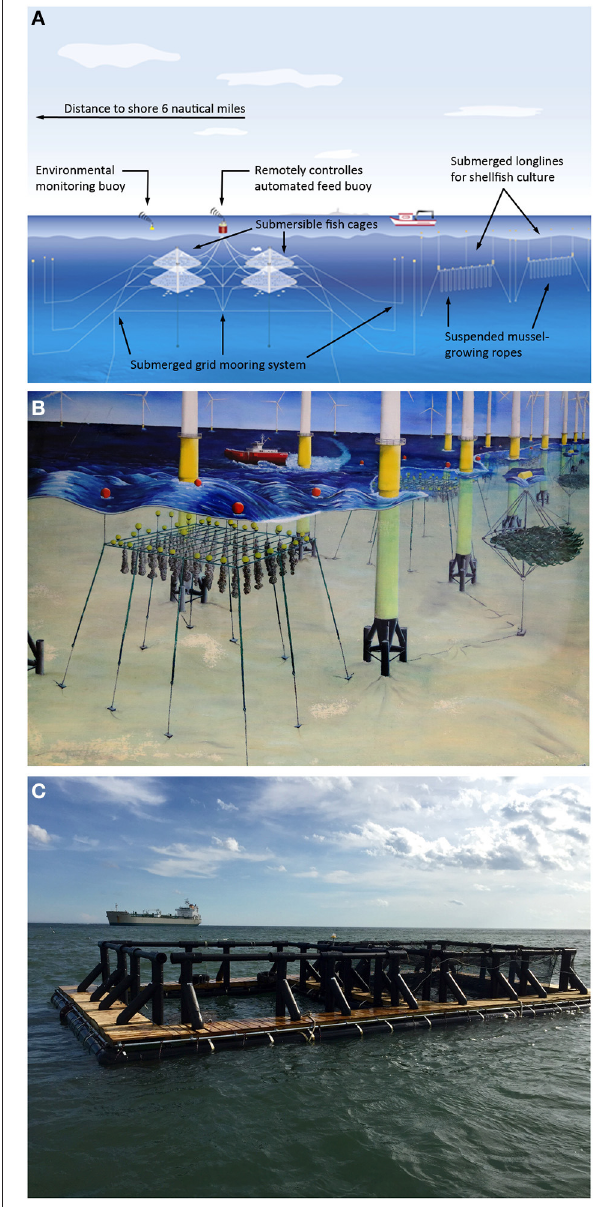
FIGURE 1 | (A–C) IMTA-trials in offshore environments. (A) Diagram of the University of New Hampshire (UNH) offshore installation depicting submerged fish cages and submerged shellfish longlines (top); (B) Extractive aquaculture in a German wind farm with seaweeds and mussels (center); (C) First pilot-scale set-up of an open ocean, integrated multi-trophic aquaculture raft with steelhead trout, blue mussels and sugar kelp deployed off the coast of New Hampshire by UNH (bottom). [Images (A,C) with permission of the publisher modified after (Buck et al., 2017b), (B) with permission of the publisher modified after (Buck and Langan, 2017)].